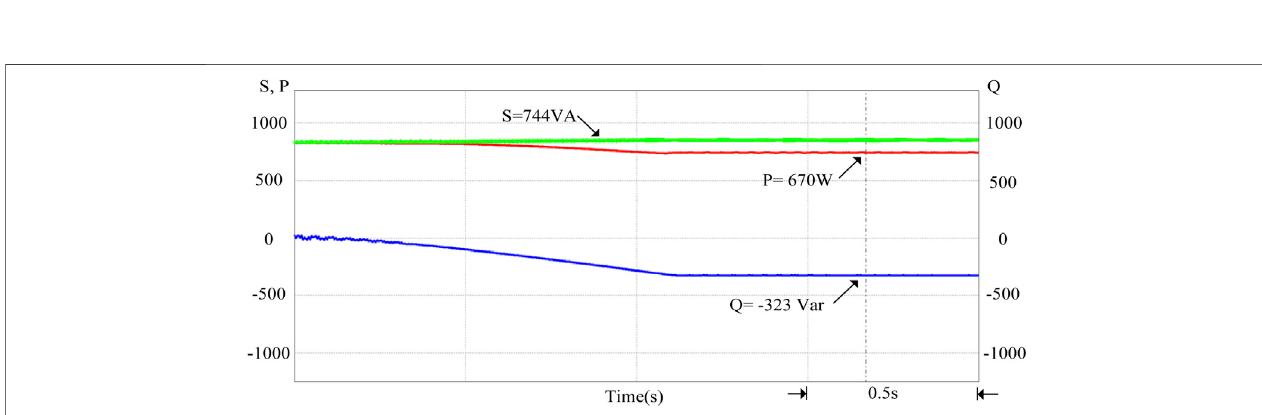
FIGURE 16 | The output power control situation of the smart inverter when the grid voltage per unit value is between 0.97 and 1 p.u.